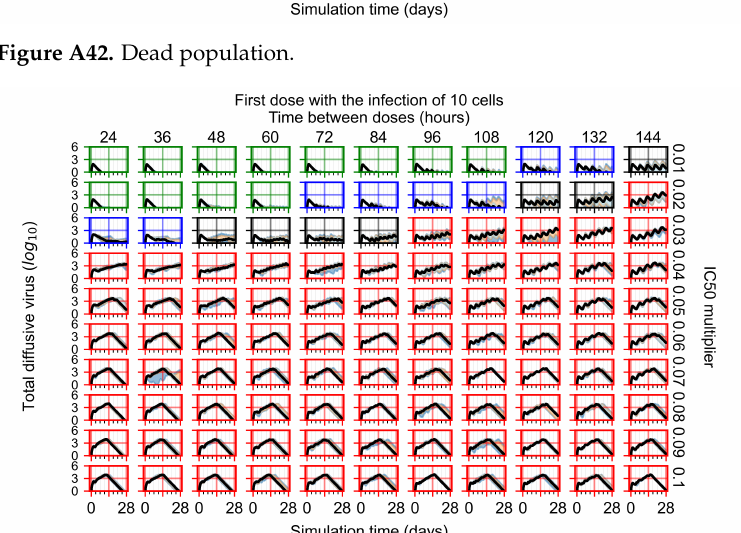
Figure A42. Dead population.